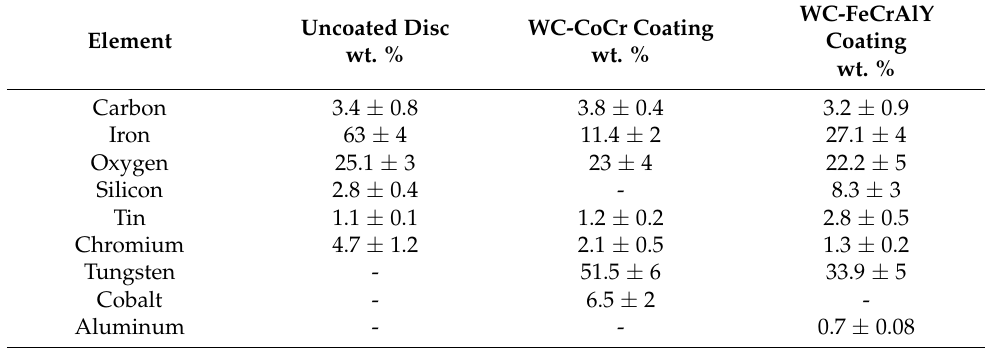
Table 3. The average composition of the friction layers that were present on the worn pin surface. WC-FeCrAlY Uncoated Disc WC-CoCr Coating Coating Element wt. % wt. % wt. % Carbon 3.4 ± 0.8 3.8 ± 0.4 3.2 ± 0.9 Iron 63 ± 4 Oxygen 25.1 ± 3